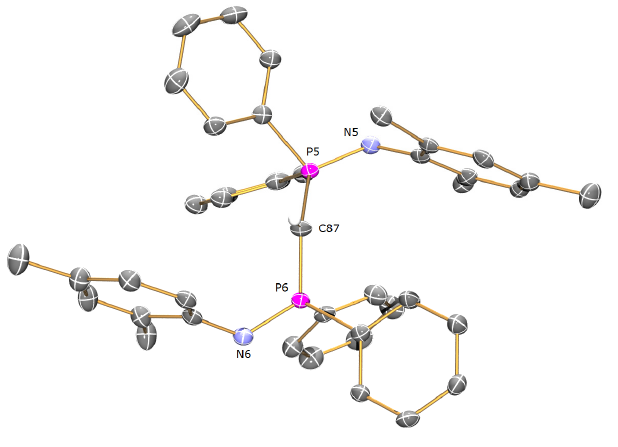
Figure 6. Anionic component of 5a 4C probability, with lattice solvent and non-methanide hydrogen atoms omitted for